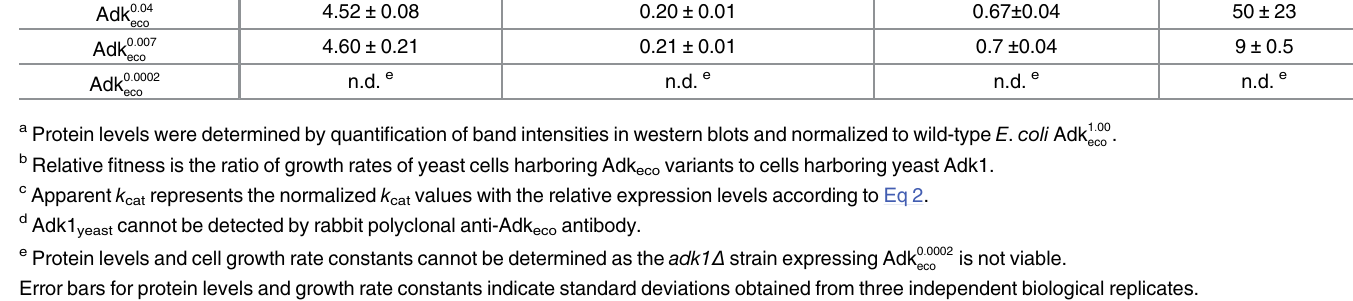
Error bars for protein levels and growth rate constants indicate standard deviations obtained from three independent biological replicates.